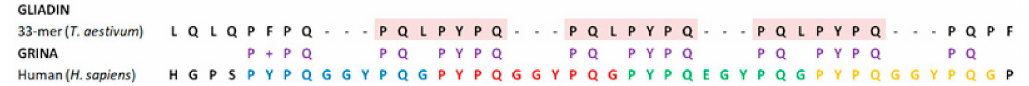
Figure 3. Homology between the 33-mer gliadin peptide and human GRINA